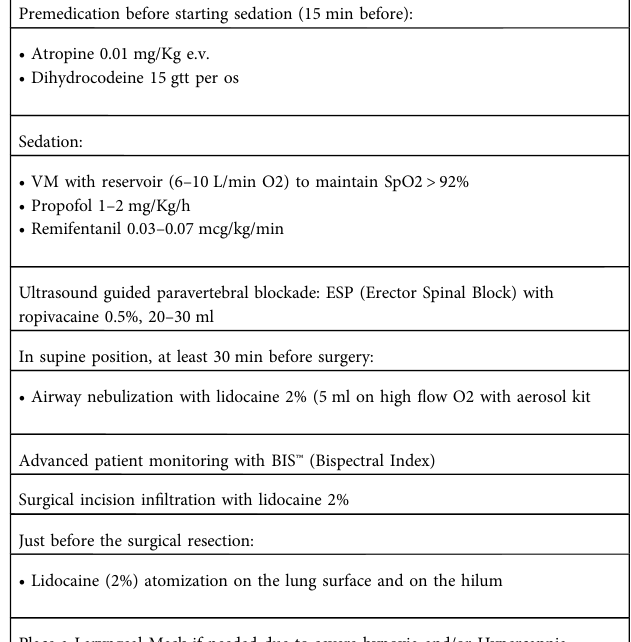
TABLE 2 Careggi university hospital anesthesiology protocol for awake lung resections. VM: VentiMask. Anesthesiology protocol for Awake Thoracic Surgery Premedication before starting sedation (15 min before):